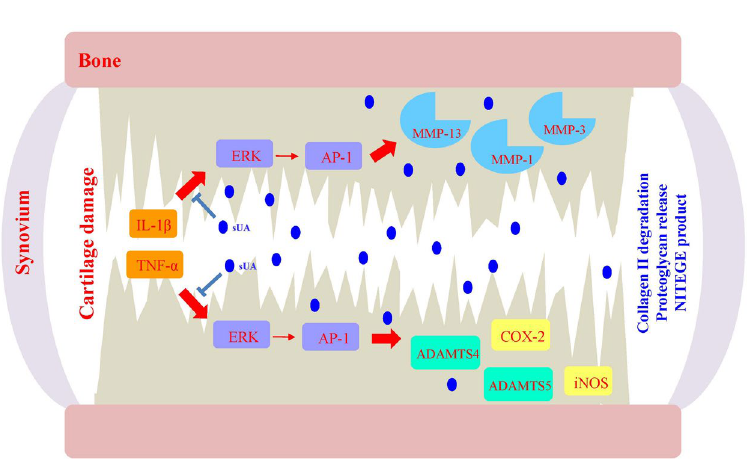
Figure 8. Illustration of the chondroprotective effects of sUA and the mechanisms underlying these effects. In joint inflammation involving both IL-1 β and TNF- α , numerous signalling pathways and cartilage-damaging enzymes are activated. The inhibitory effects of sUA on the ERK-AP-1 signalling pathway were observed at a wide range of physiological concentrations of sUA. The ERK-AP-1 pathway targeted by sUA likely contributes to the activation of cartilage-damaging enzymes, such as MMP and ADAMTS, and inflammation-related molecules, such as iNOS and